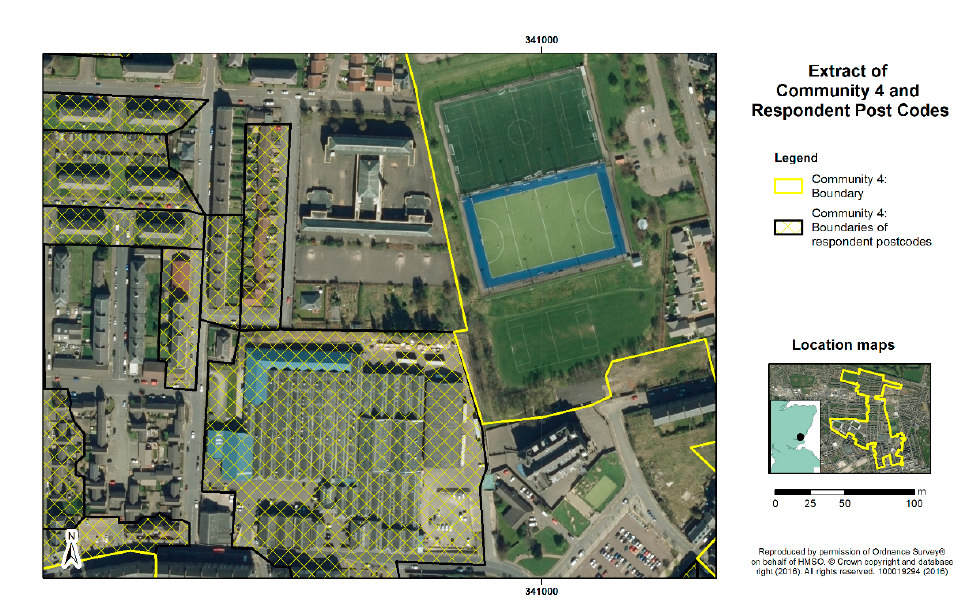
Figure 4. Aerial view of typical residential neighbourhood in Community 4.